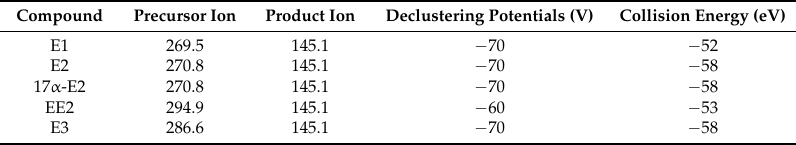
Table 1. Main mass fragments of the target